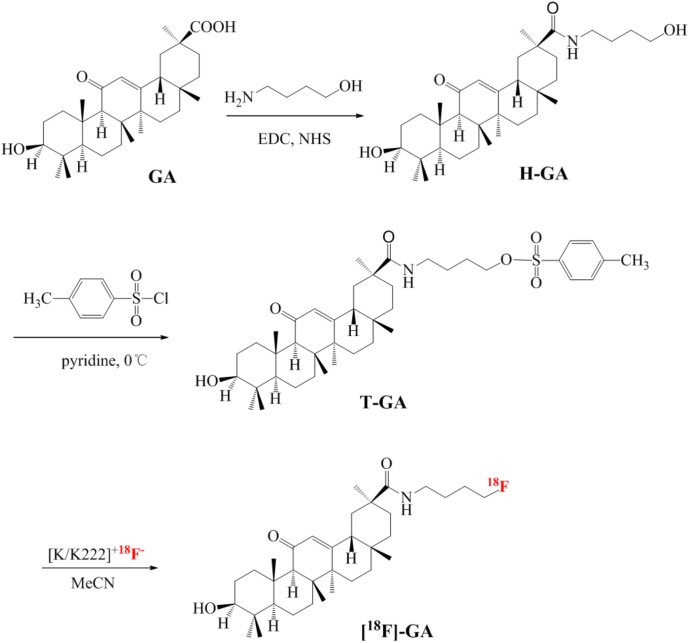
The synthetic strategy of [18F]-GA.